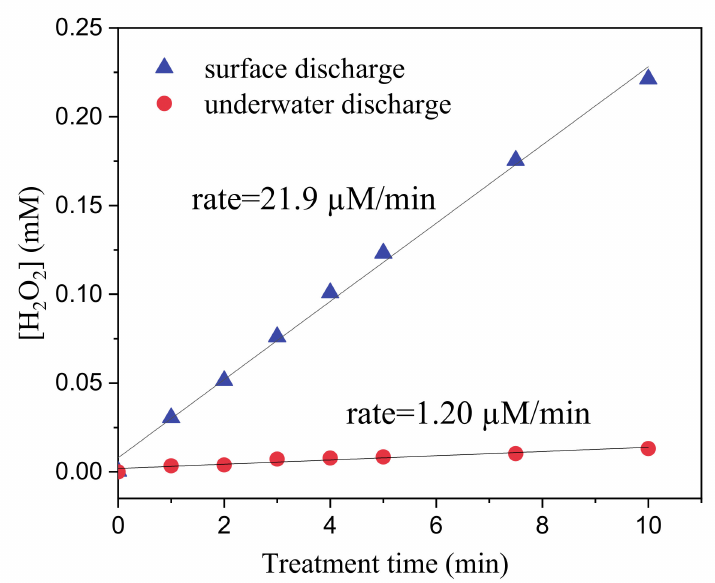
Figure 3. Concentration of hydrogen peroxide produced during plasma treatment of 50 mL of ultrapure water in PG reactor with surface and underwater